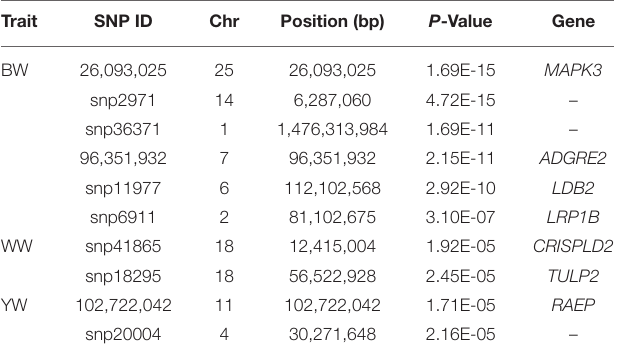
TABLE 2 | Significant single-nucleotide polymorphisms (SNPs), associated traits, and candidate genes identified in genome-wide association studies (GWASs). Trait